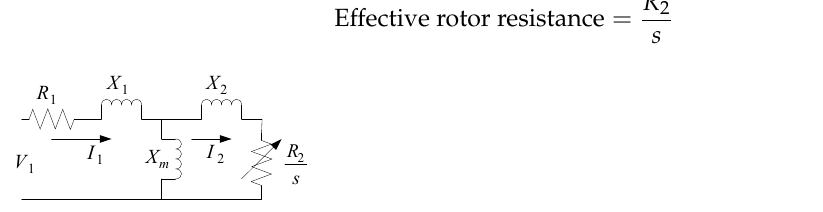
Table 8. Summary of the comparative studies.